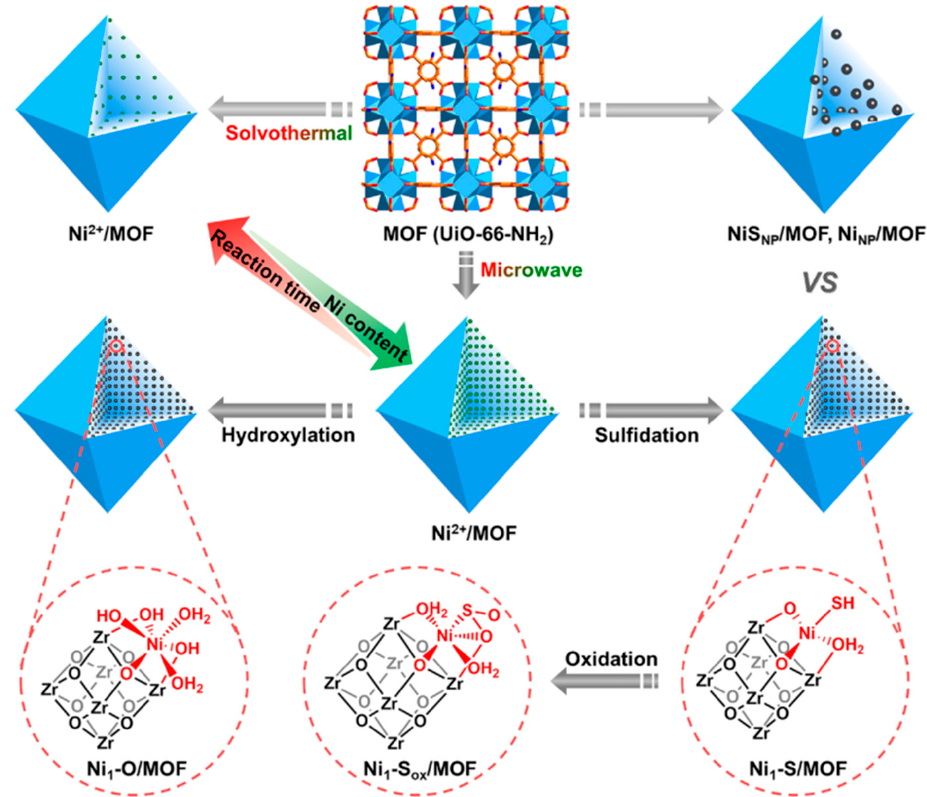
Figure 1. The illustration of the synthetic strategy for UiO-66-NH 2 with Ni 2+ encapsulated via an efficient microwave-assisted method and the follow-up coordination environment modulation of single Ni atom to obtain Ni 1 -X/MOF, in contrast to Ni NP /MOF and the NiS NP /MOF via one-pot synthesized. Reproduced with permission from Ref. [61].